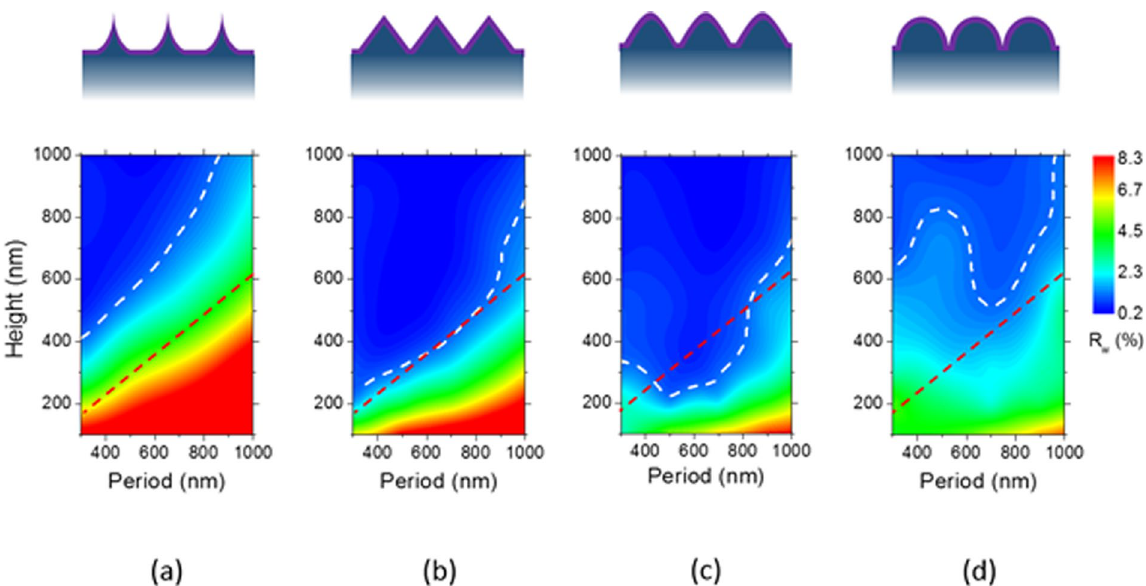
Figure 4. Simulated average weighted reflectance values of Si wafers with different shapes of Si nanostructures as a function of heights and periods: ( a ) curved cone, ( b ) nanocone, ( c ) paraboloid, ( e ) ellipsoid. The white dashed lines denote a contour line of a 1% reflectance. Schematics of cross sectional views of each nanostructure is illustrated together. The red dashed lines indicate the maximum height of the Si nanostructures to be achieved with a etch selectivity in the CF 4 /O 2 RIE process in this